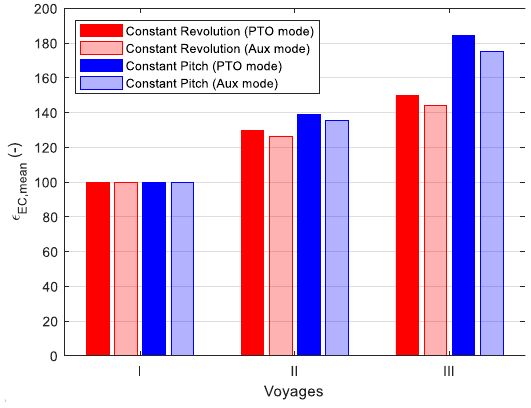
Figure 3. Mean value of energy conversion effectiveness.